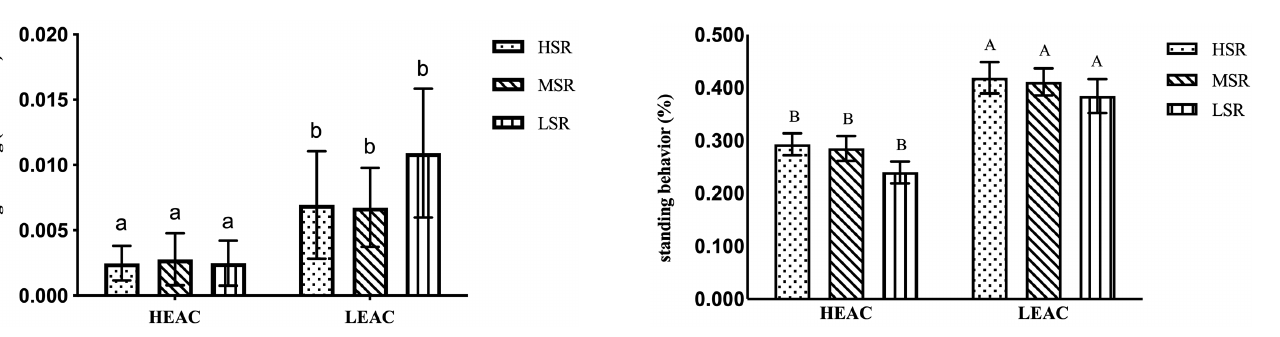
Figure 1. Effects of hen’s social ranking order (SRO) on vertical wing shaking in high and low enrichments allocation cages (HEAC and LEAC). a,b p<0.01.